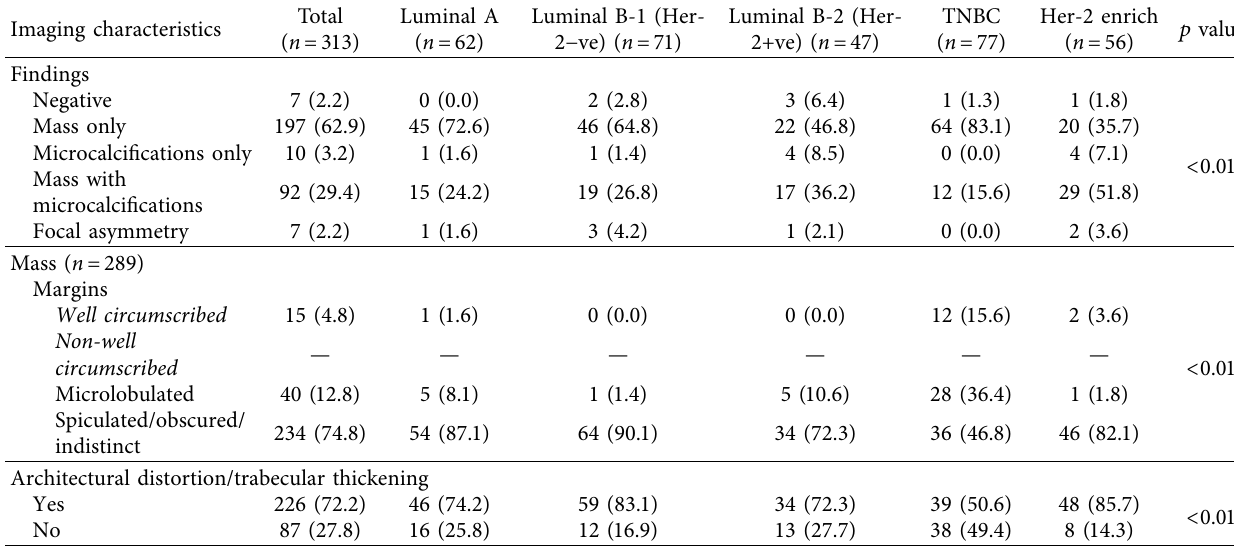
Table 4: Mammographic